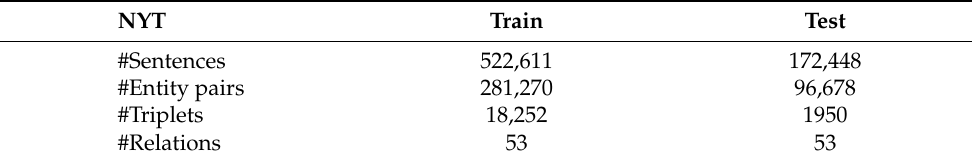
Table 1. Statistics of NYT